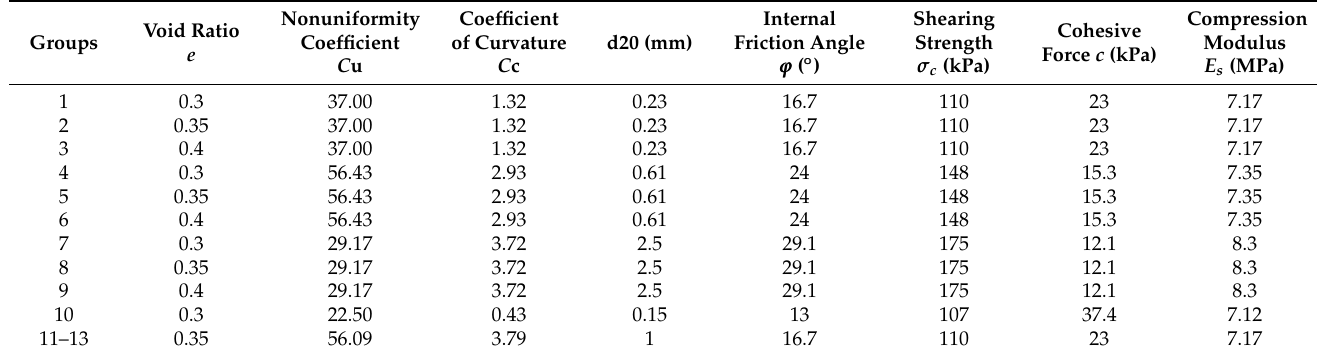
Table 2. Injected media parameters.